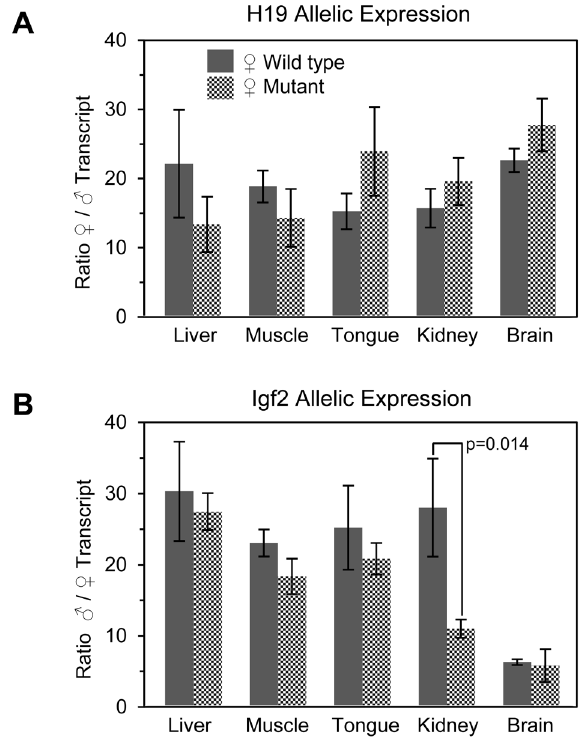
Figure 7. Allelic H19 and Igf2 mRNA expression ratios in neonatal mice. SNuPE analysis was carried out on (A) H19 and (B) Igf2 cDNA from 4 dpn heterozygous mice having a paternally inherited WT M. cast . allele and a maternally inherited WT or mutant B6 allele. The ratio of transcript for each tissue was determined by averaging the individual allelic ratios for 3–5 different mice. Error bars represent the standard deviation of the mean. The p values were generated using Student’s